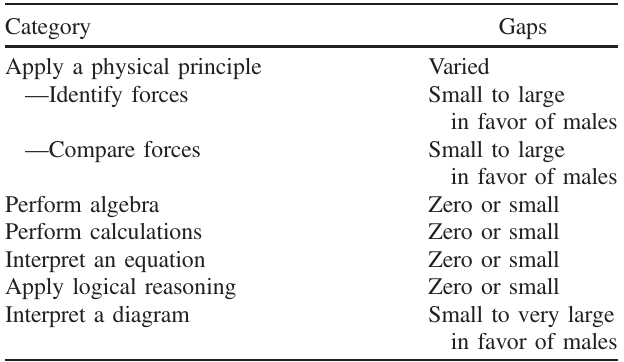
TABLE IV. Pattern of gender gaps within the process dimen- sion. Note that “ Identify forces ” and “ Compare forces ” are subcategories within “ Apply a physical principle ” .